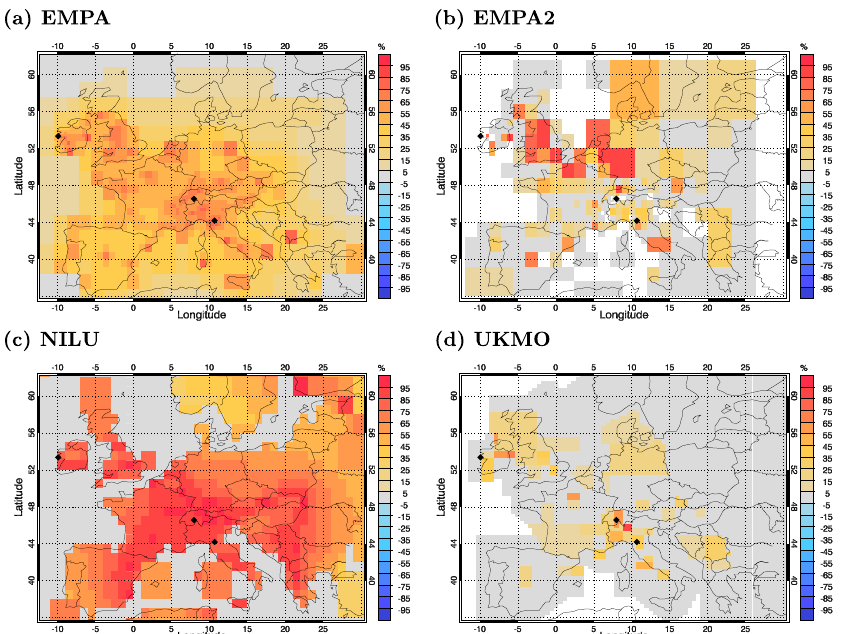
Figure 10. Uncertainty reduction (1 − u post /u prior ) in percent for HFC-134a (experiment M2). For EMPA, the reduction is shown in terms of reduction of relative uncertainties: 1 − ( u post /x post )/(u prior /x prior )